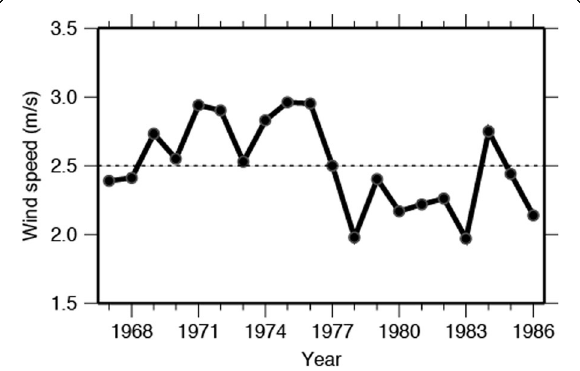
Fig. 18 Time series of alongshore wind speed used as input to the historical simulation. Values are averaged from October to April. The values from October to December are grouped with the following year. Broken lines represent average values computed over 1967 to